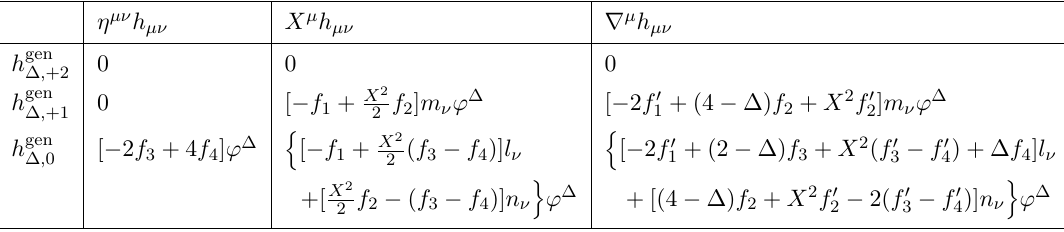
Table 8. Various constraints one can impose on a generalized conformal primary